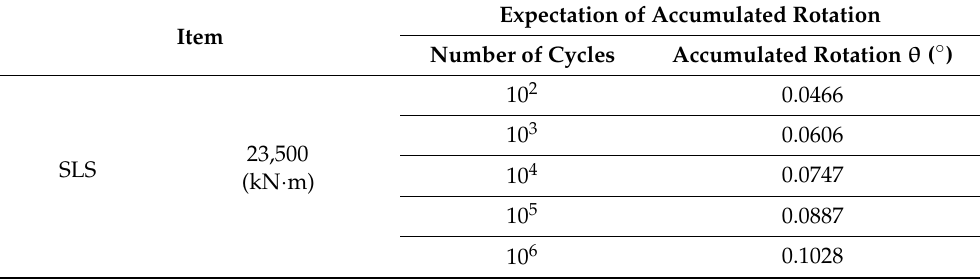
Table 6. Predictions of long-term permanent rotation of on-site